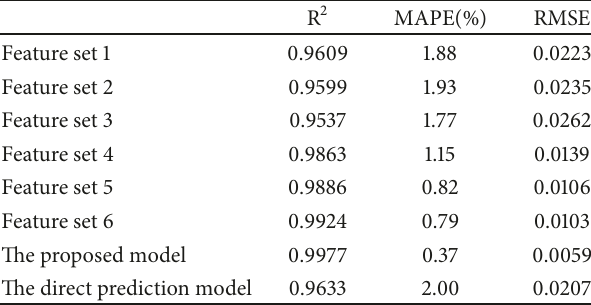
Table 7: The estimates errors of prediction results.